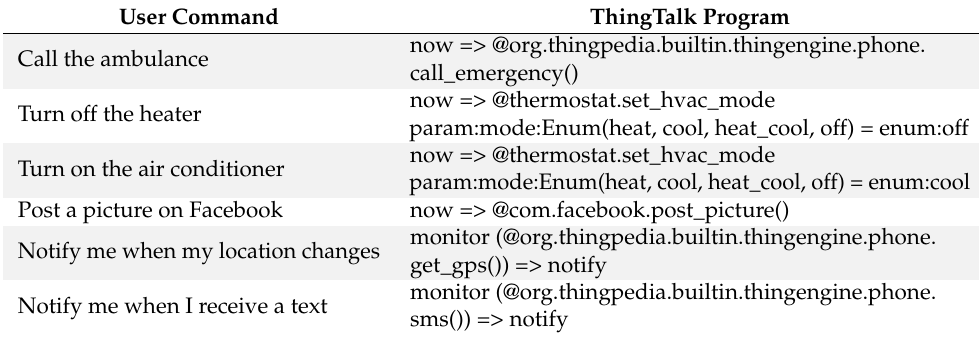
Table 1. User command examples in English and their corresponding ThingTalk program.